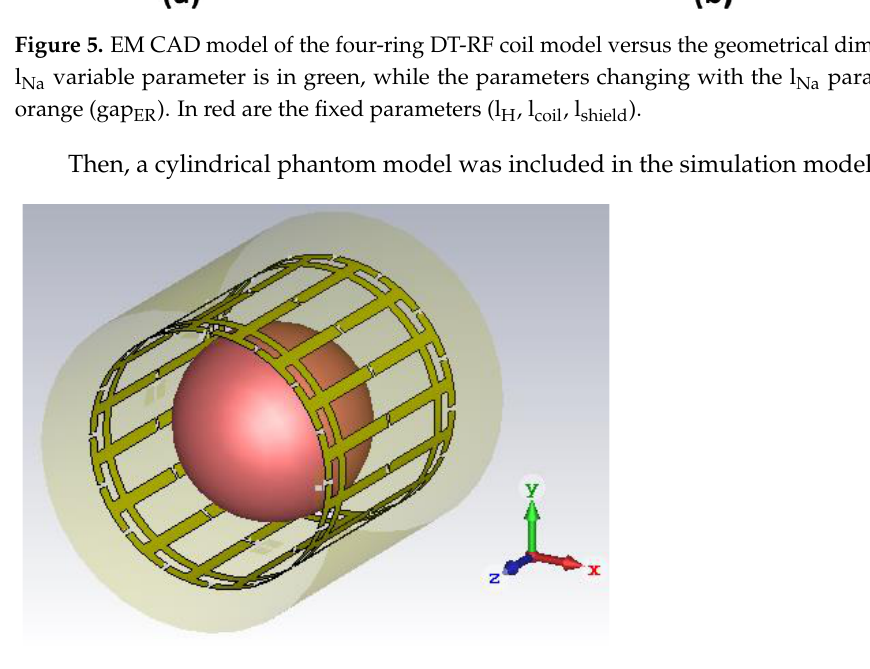
Figure 6. EM CAD model of the four-ring DT-RF coil model with the spherical phantom positioned at the center.